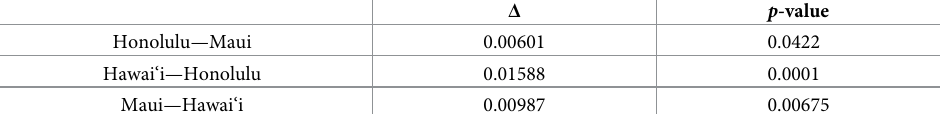
Table 6. The difference, Δ , between the mean differences in L 2 -norms for the intervals before Oct. 15 and the one until Jan 15, along with the p -value estimated using the permutation test.